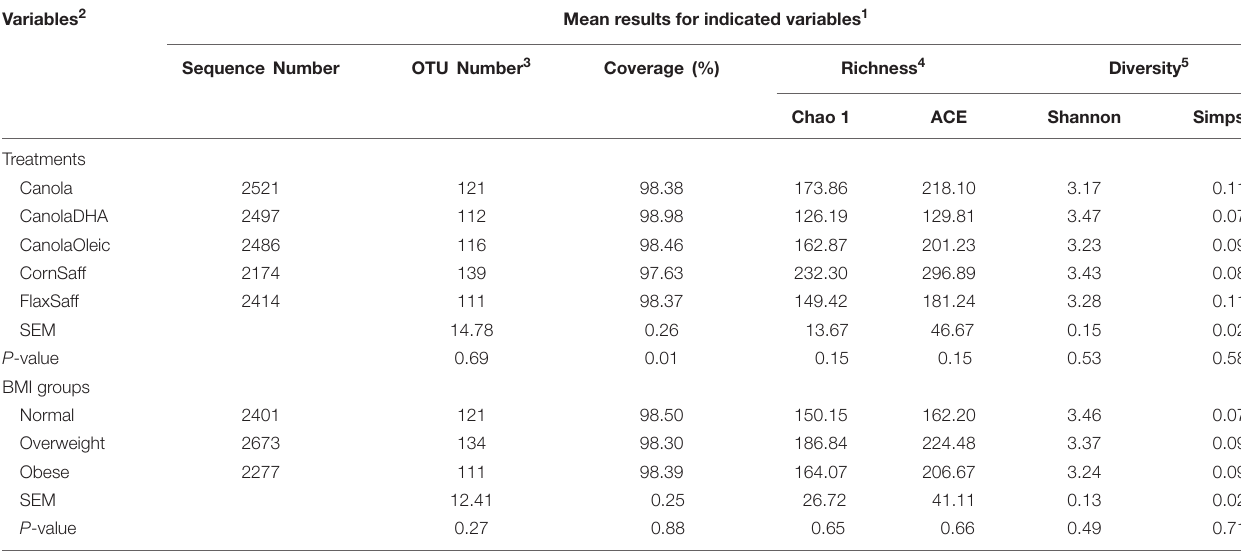
TABLE 2 | Summary statistics for sequences using 16S rRNA gene